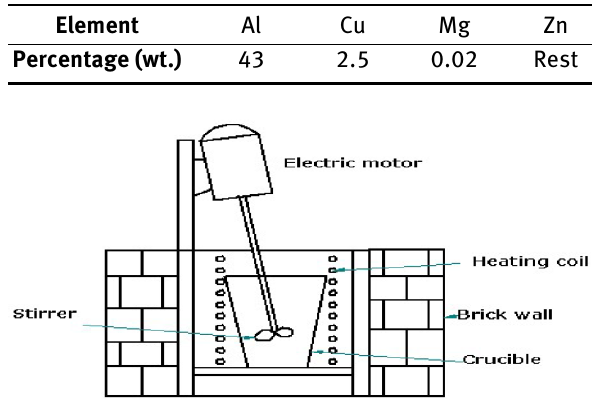
Figure 1: Stir casting mechanism for casting